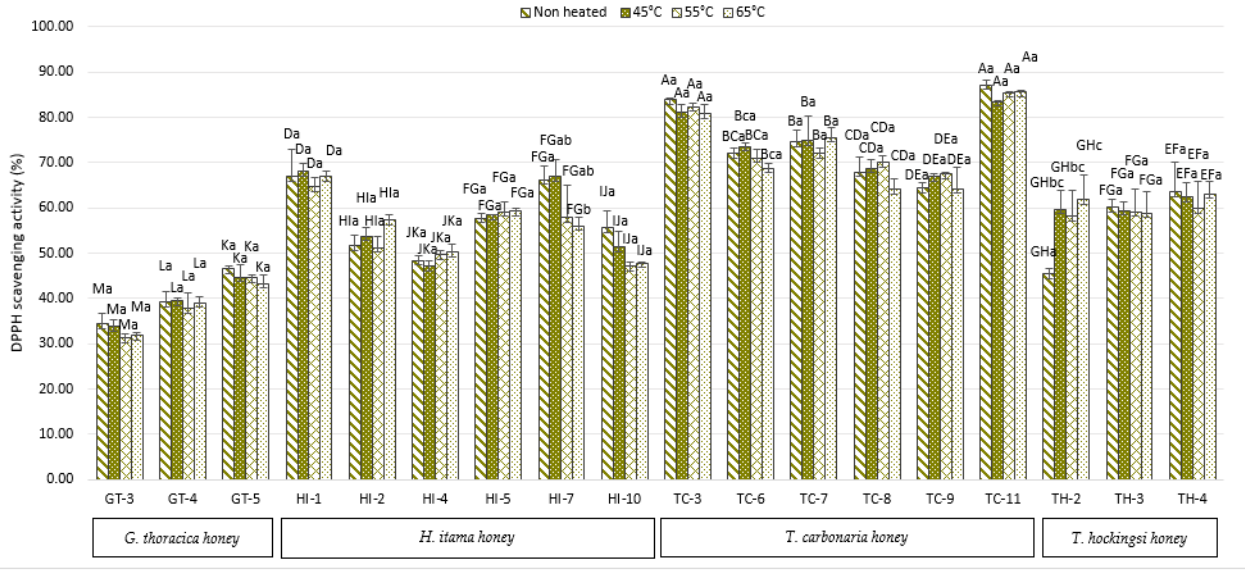
Figure 3. Percentage of the DPPH inhibition of Malaysian and Australian stingless bee honey. Different superscripts, a–c, indicate significant differences ( p < 0.05) between the temperatures, and different superscripts, A–M, indicate significant differences ( p < 0.05) between the stingless bee